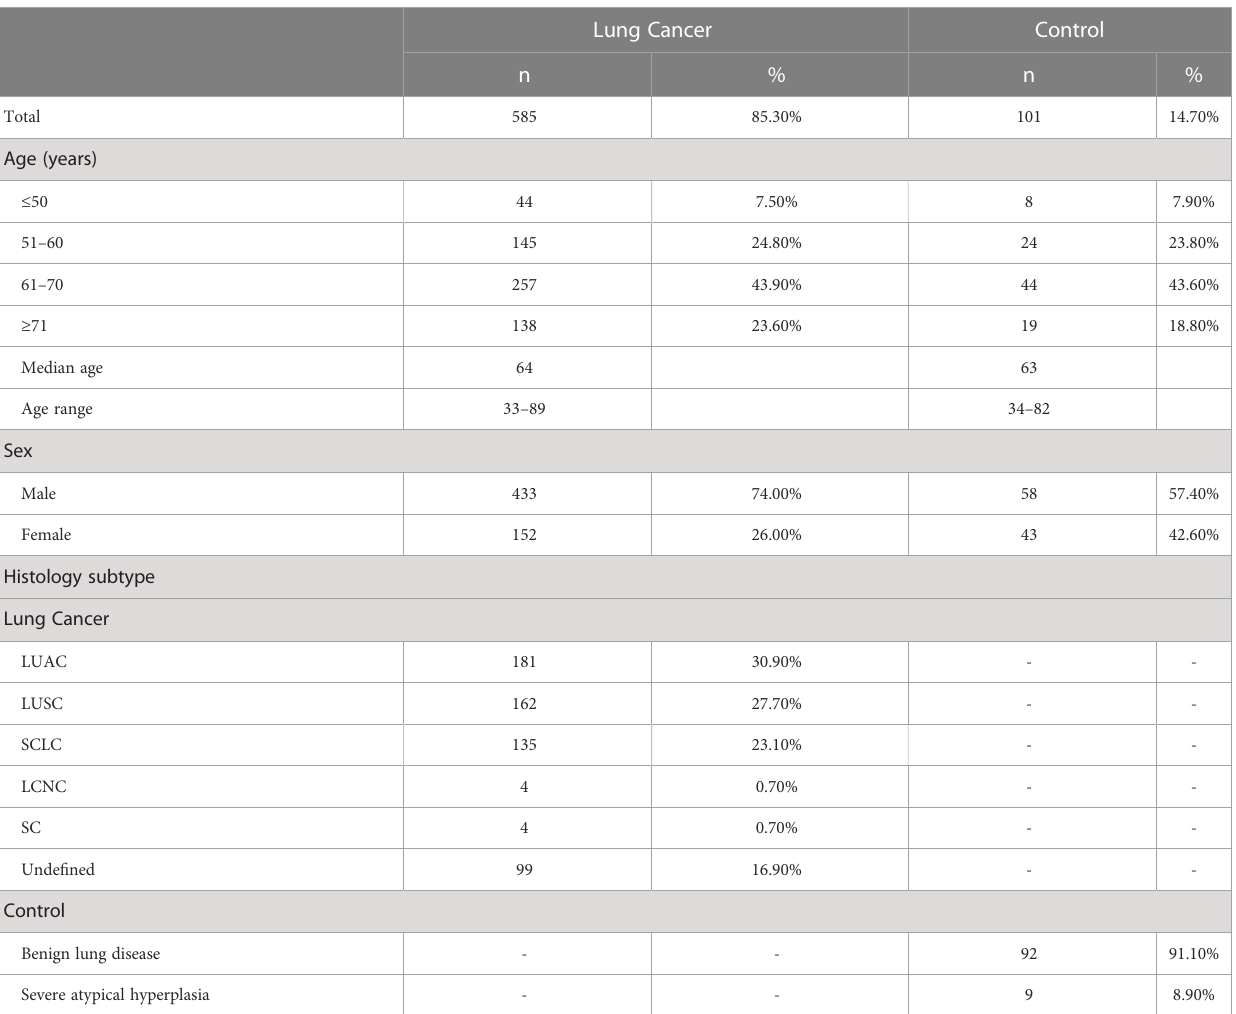
TABLE 1 Demographic and clinical features of the